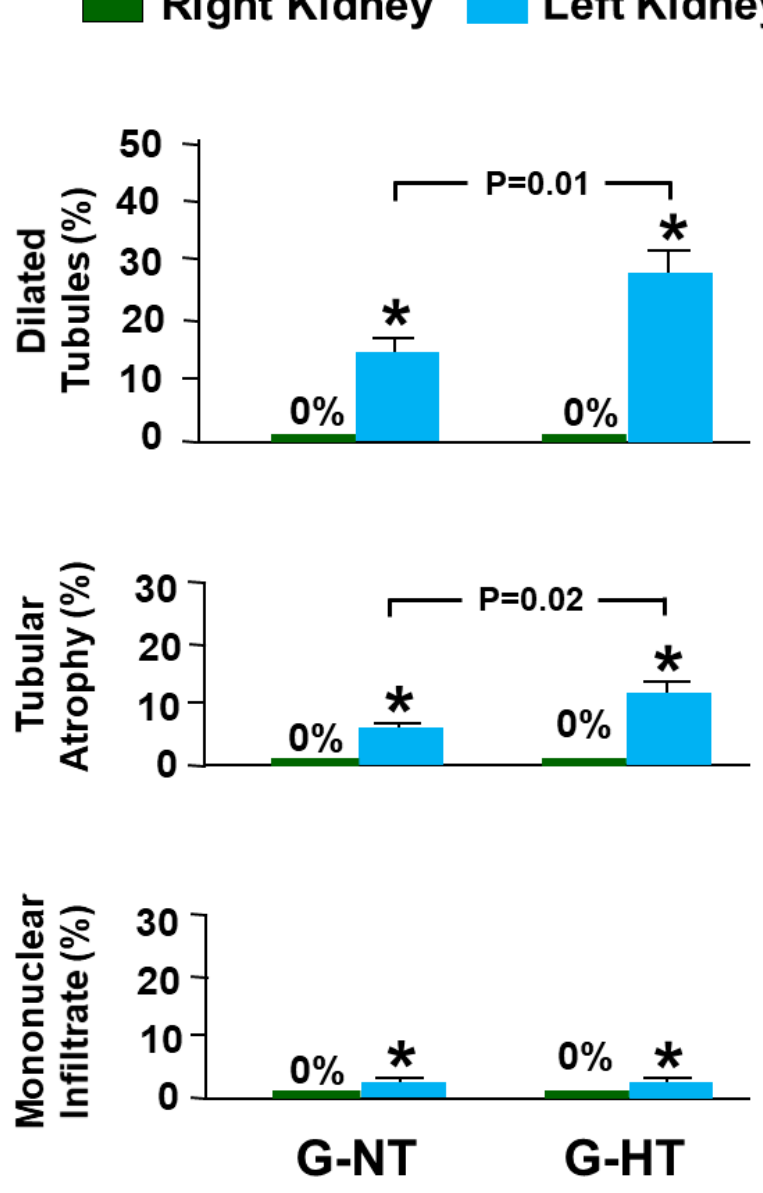
Figure 7. The score of various histological features in the left post-obstructed kidney (POK) and the right non-obstructed kidney in the G-NT and G-HT groups; s. Values represent mean ± SEM; * indicates statistical significance compared with right NOK in the same group.